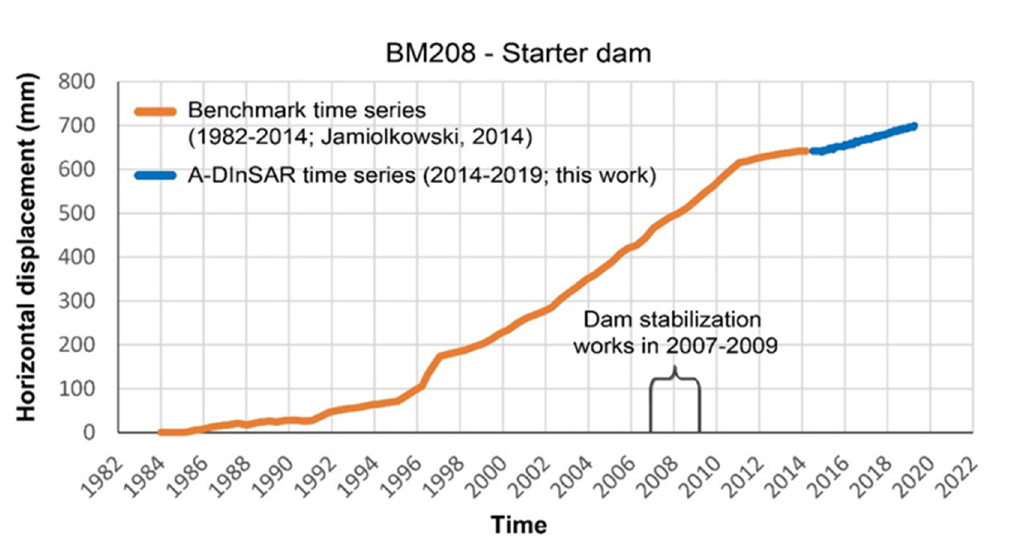
Figure 9. Time series of horizontal surface displacements of benchmarks BM-208; orange line: benchmark time series from [1]; blue line: A-DInSAR time series.